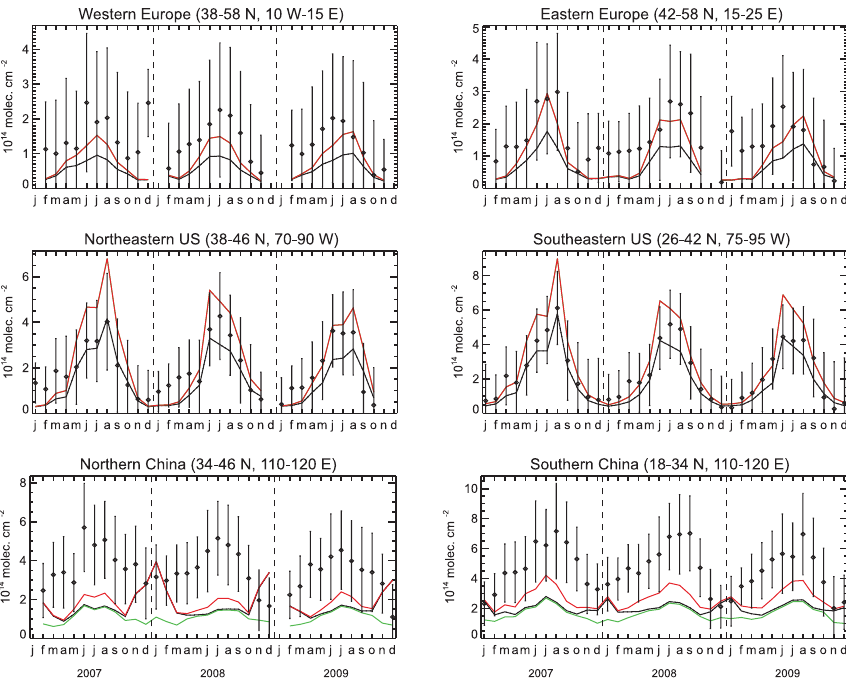
Fig. 12. Modelled and observed glyoxal column time series over selected large mid-latitude regions. The standard model simulation S0 is shown in black. The simulations S1 (with doubled isoprene emissions) and S2 (without the biofuel glyoxal source) are shown in red and green, respectively. Error bars represent the total errors on the observed columns as calculated in Sect. 3.